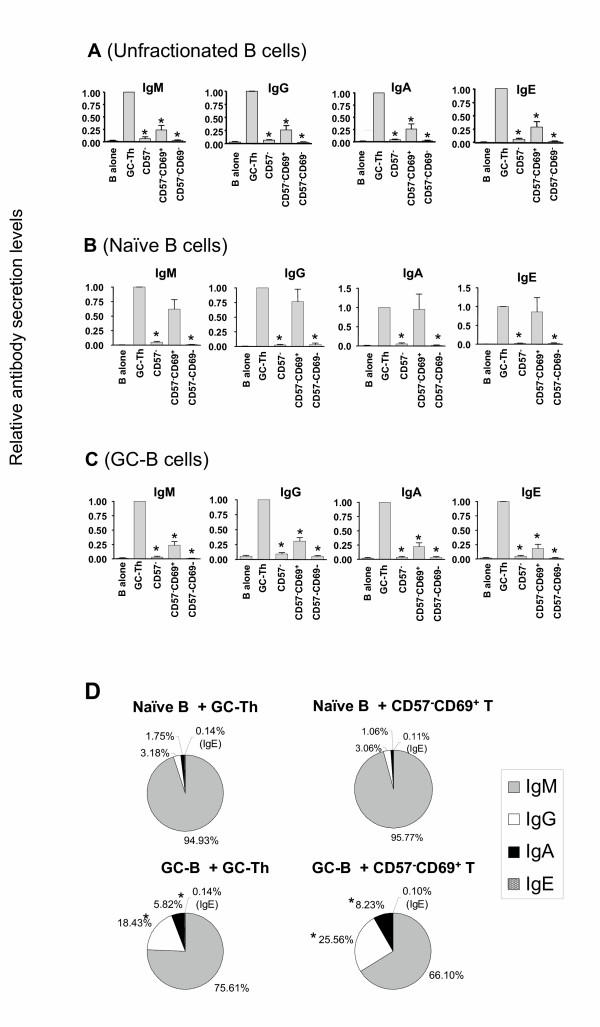
CD57+ GC-Th cells are more efficient than other tonsil CD4+ T cell subsets in helping B cells. (A) CD4+ T cell subsets were cultured with total tonsil CD19+ B cells for 7 days in the presence of SEB. Naïve B cells (C) or GC-B cells (D) were cultured with equal numbers of CD57+GC-Th cells or other T cell subsets (CD57-, CD57-CD69+ and CD57-CD69- T cells) for 7 days followed by ELISA for IgM, IgG, IgA and IgE. Data from 5 independent experiments were combined and the averages are shown with standard errors. Relative production levels to CD57+ GC-Th cells are shown. *Significant differences from CD57+ GC-Th cells. The absolute Ig production levels (ng/ml) in panel A (GC-Th + Total B cells) were 5737 ± 1764 (IgM), 2111 ± 1185 (IgG), 577 ± 186 (IgA), and 4.8 ± 2.1 (IgE). The absolute Ig production levels (ng/ml) in panel B (GC-Th cells + naïve B cells) were 2045 ± 697 (IgM), 63 ± 21 (IgG), 40 ± 23 (IgA), and 2.9 ± 1.2 (IgE). The average levels (ng/ml) of Ig produced in the cultures of GC-Th cells and GC B cells were 750 ± 279 (IgM), 175 ± 52 (IgG), 51 ± 13 (IgA), and 1.0 ± 0.5 (IgE). (D) Isotype composition of the Ig induced by CD57+ GC-Th cells. Naïve B cells or GC-B cells were cultured with equal numbers of CD57+GC-Th cells or CD57-CD69+ T cells for 7 days followed by ELISA for IgM, IgG, IgA and IgE. Data from 4 independent experiments were combined and the averages are shown with standard errors. *Significant differences between naïve and GC-B cells, but not between the two T cell subsets, were observed.